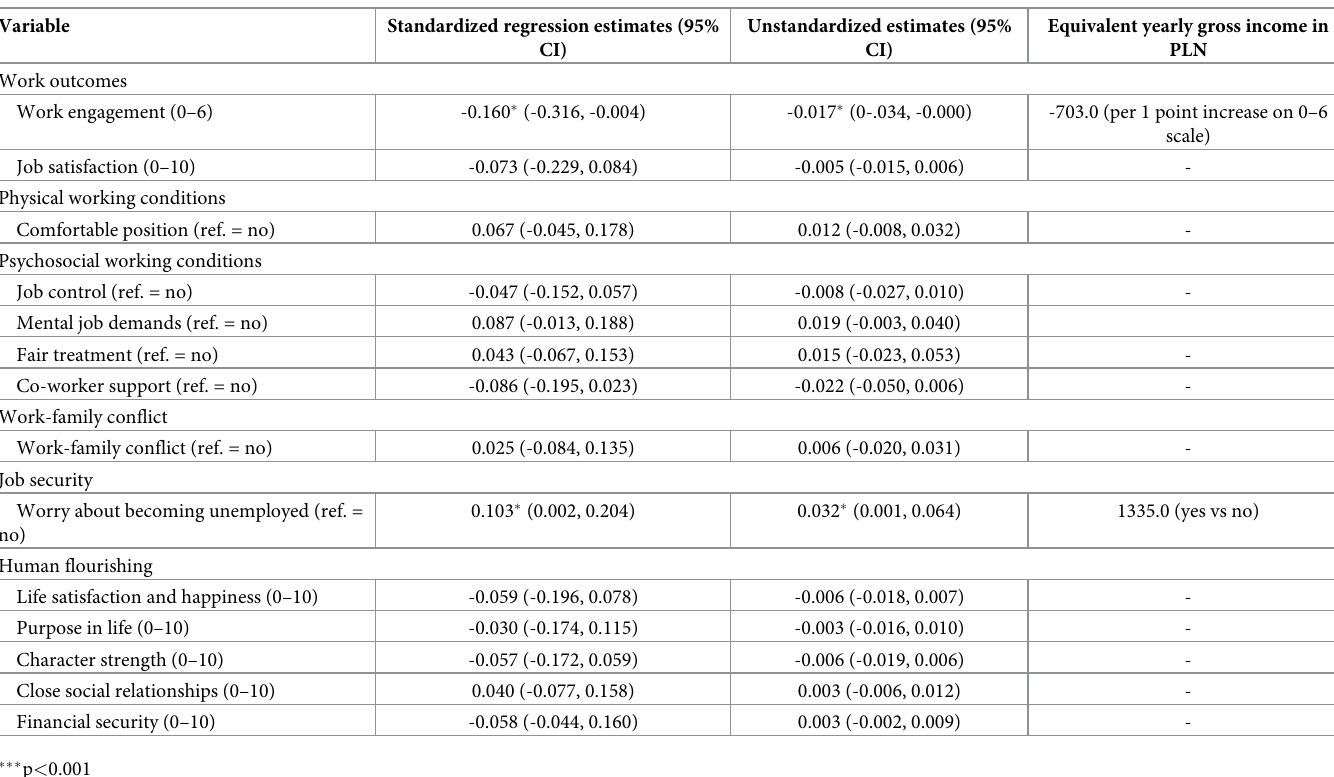
Table 5. Contribution to productivity loss and cost of productivity loss at the organizational level–secondary analysis of an apparel factory belonging to a global